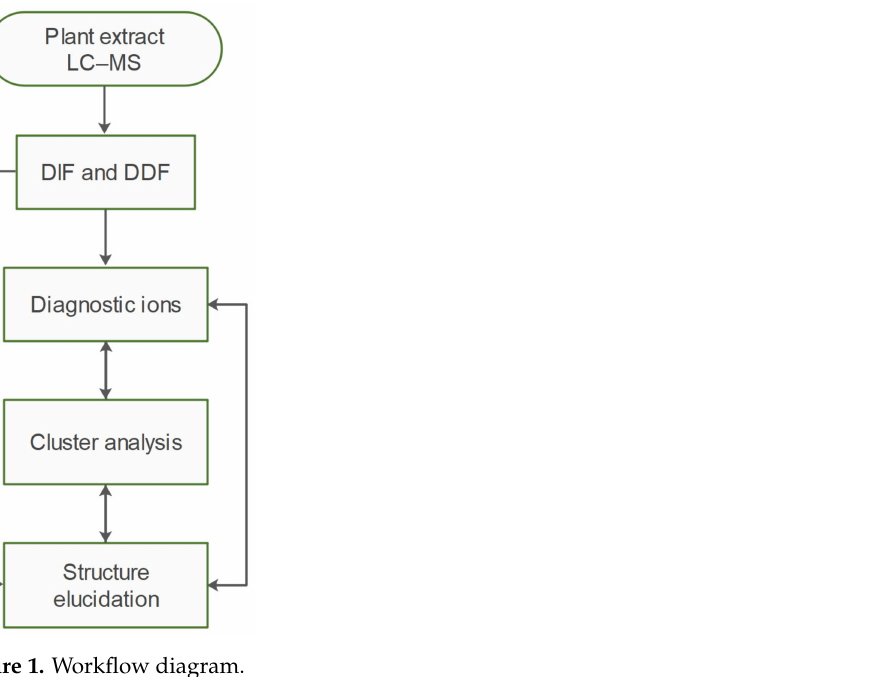
Figure 1. Workflow